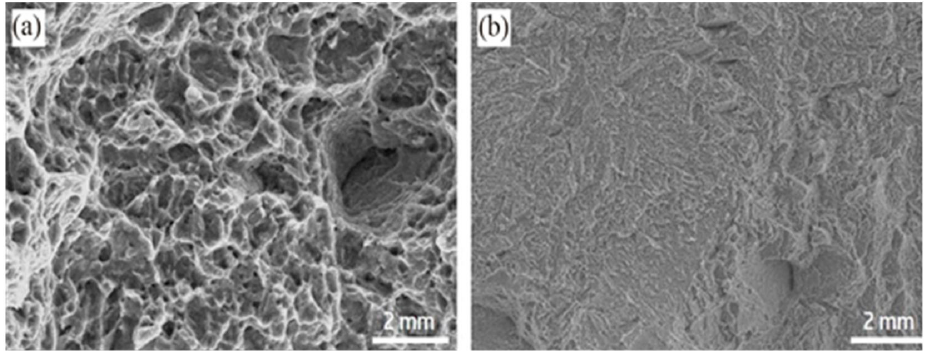
Figure 17. Images of the tensile fracture surfaces; ( a ) the underwater welded joint; ( b ) the in-air welded